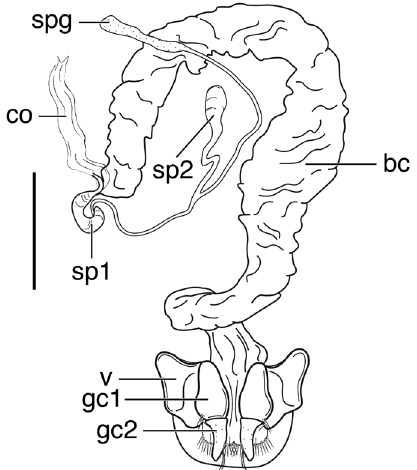
Figure 12. Line drawing of female reproductive tract of Neodiachipteryx cariniger (Putzeys). Legend: bc bursa copulatrix co common oviduct gc1 gonocoxite 1 gc2 gonocoxite 2 sp spermatheca spg spermathecal gland spgd spermathecal gland ductaaaa v valvifer. Scale bar 1